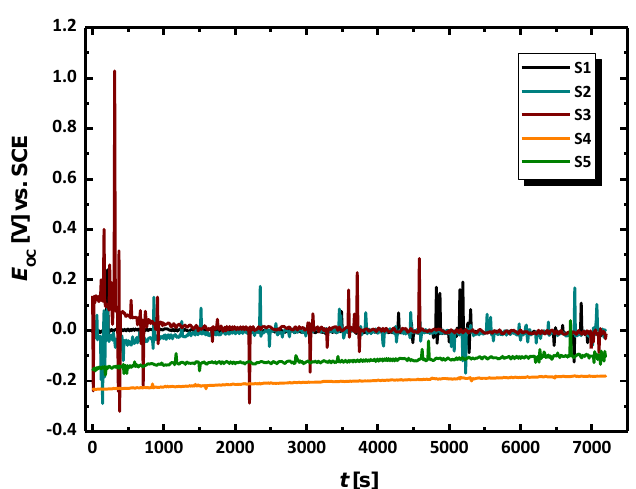
Figure 4. Open circuit potential for the AISI 1010 carbon steel electrode in sulfolane at 25 ◦ C for S1 electrode after the experiment in pure sulfolane at 95 ◦ C and etching; S2 electrode after the experiment in sulfolane with the addition of 1 vol.% of water at 95 ◦ C and etching; S3 electrode after the experiment in sulfolane with the addition of 2 vol.% of water at 95 ◦ C and etching; S4 electrode after the experiment in sulfolane with the addition of 3 vol.% of water at 95 ◦ C and etching; and S5 electrode after the experiment in sulfolane at 95 ◦ C and without etching of corrosion products.